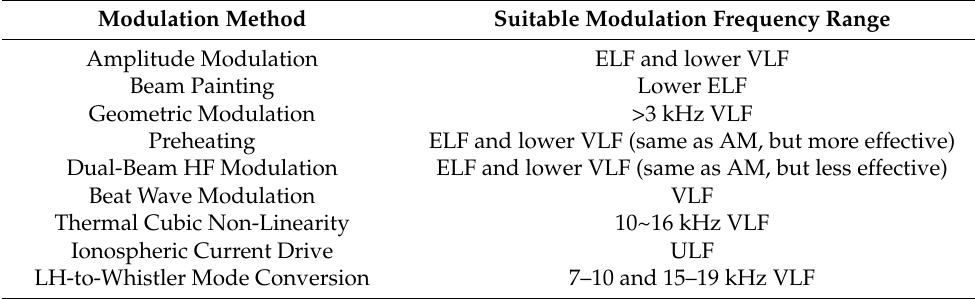
Table 2. Suitable modulation frequency range for each modulation